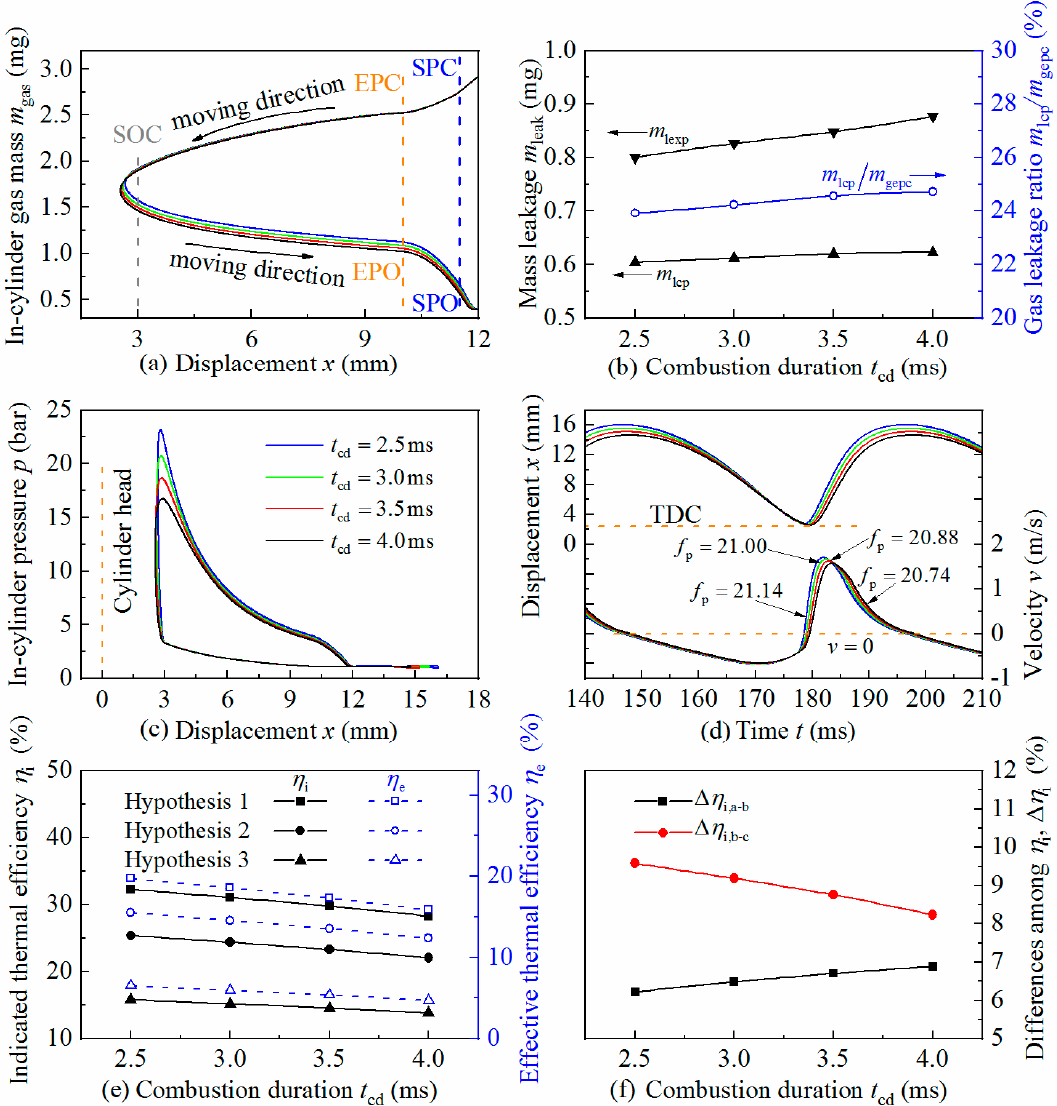
Figure 9. The influence of combustion duration on leakage and system performance. ( a ) Mass variations of in-cylinder gas in function of stroke; ( b ) Mass leakage; ( c ) Pressure variations of in-cylinder gas in function of stroke; ( d ) Piston dynamic characeristics; ( e ) Thermal efficiencies; ( f ) Indicated thermal efficiency drops. Figure ( a , c , d ) apply the same legend displayed in figure ( c ). The blue, green, red and black solid lines stand for the combustion durations of 2.5, 3.0, 3.5 and 4.0 ms, respectively. The symbol f p in figure ( d ) stands for piston frequency, Hz.